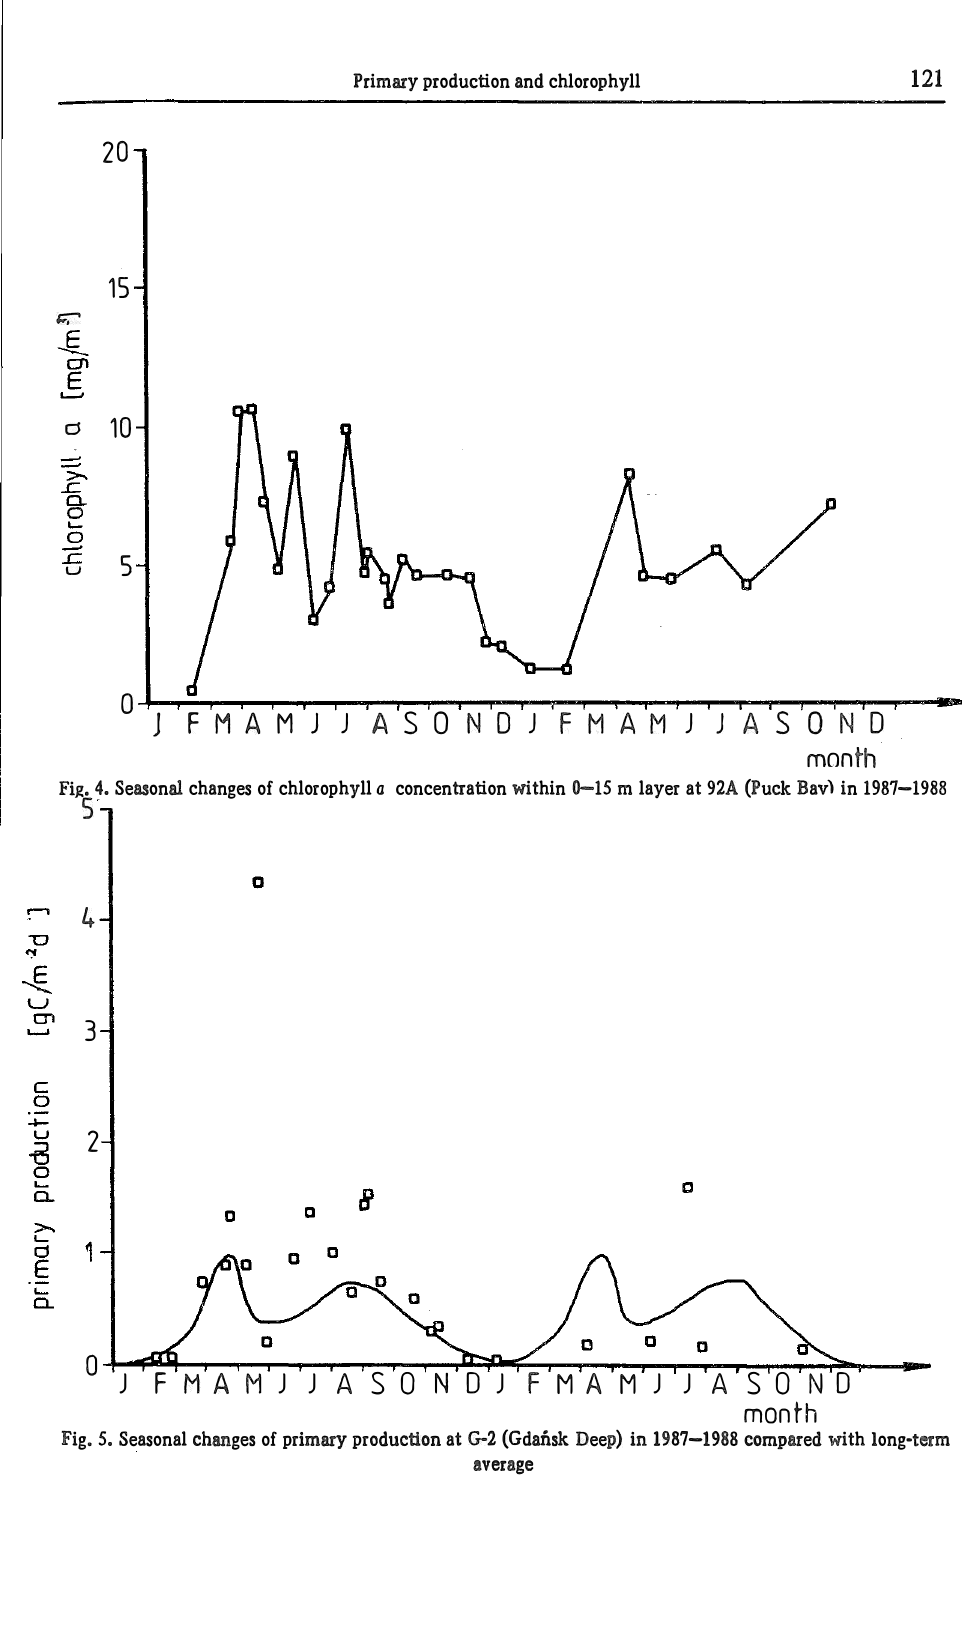
Fig. 5. Seasonal changes of primacy production at G-2 (Gdaiisk Deep) in 1987-1988 compared with